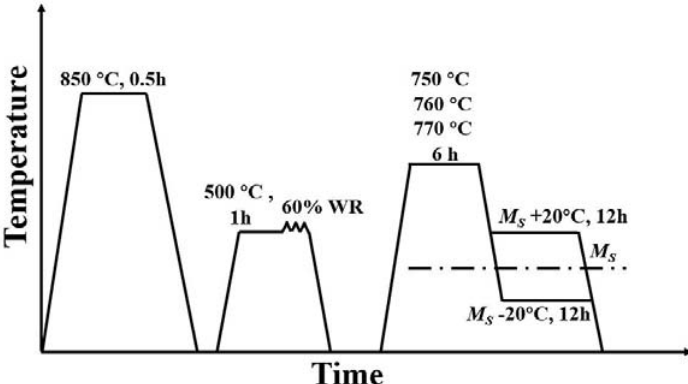
Figure 1. Schematic illustrations of the thermomechanical process.